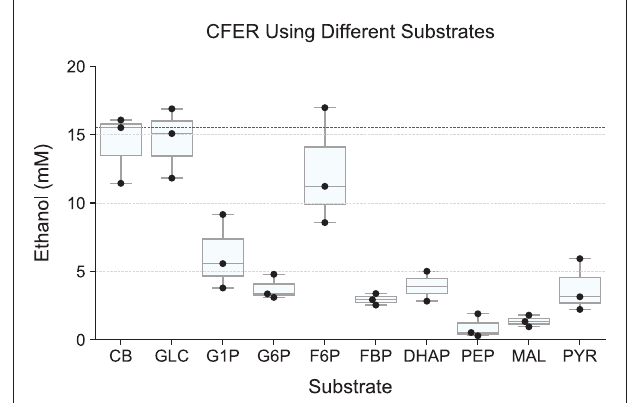
FIGURE 5 | Starting the CFER with different metabolites as substrate. Intermediates in glycolysis were used as substrate to start the CFER in order to bypass specific enzymes. Since the substrates have different carbon backbones, the concentration used was adjusted to 30mM C3 carbon equivalents. Explicitly, 15mM CB, 30mM GLC, G1P, G6P, F6P, and FBP, 60mM DHAP, PEP, MAL, and PYR ( Supplementary Table 1 ). Ethanol production was measured after 48h of incubation. Individual replicates are plotted as black dots. The red dotted line represents the median production of ethanol in the CB control group. Whiskers of the boxplot represent 1.5 × interquartile range (IQR). See Figure 1 for metabolite abbreviations. Raw data included in Supplementary Table 7